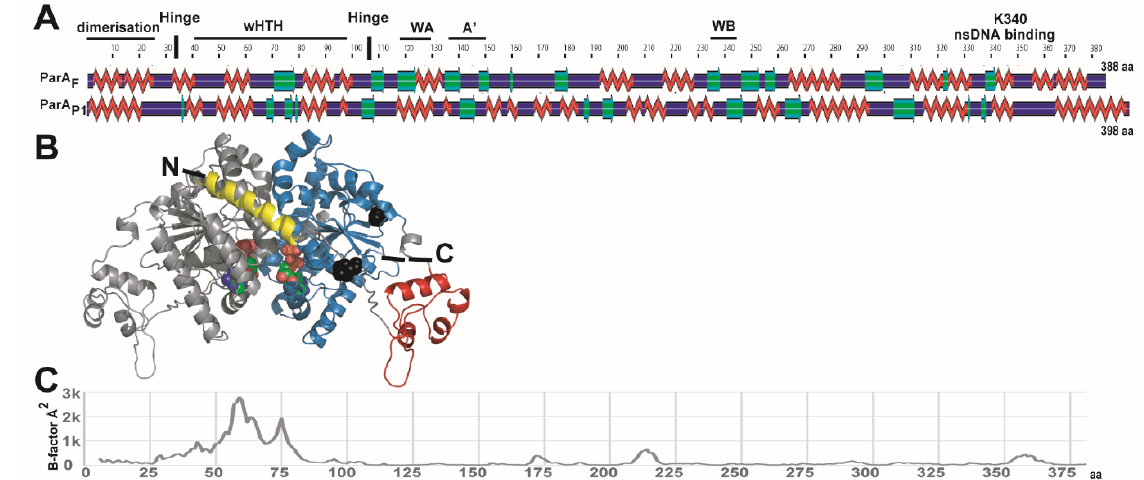
Figure 4. Structural similarity of ParA F with ParA P1 . ( A ) Alignment of secondary structures predicted for ParA F (388 aa) and derived from X-ray crystallography for ParA P1 (398 aa). The comparison was generated by POLYVIEW2D. α -helices and β -sheets are displayed in red and green, respectively. Domains and motifs for ParA F are indicated as follows: dimerization (1–27 aa), wHTH (winged helix turn helix; 40–100 aa), WA (Walker A; 114–122 aa), WA’ (Walker A’; 139–149 aa), WB (Walker B; 246-251 aa), nsDNA binding K340 (lysine 340). Vertical bars represent Hinge positions predicted by HingeProt analysis. ( B ) Model of ParA F 3D structure generated by Swiss-Model using ADP-ParA P1 structure as a reference (see Materials and Methods). The two monomers are colored separately in grey and blue. For the right monomer, the first α -helix and the wHTH are displayed in yellow and red, respectively, and the Nter (N) and Cter (C) are indicated. Hinge positions are represented by black spheres. Each monomer contains an ADP represented with spheres, red for oxygen (O), green for carbon (C), blue for nitrogen (N) and orange for phosphate (P). ( C ) The wHTH of ParA F undergoes a large conformational change. The B-factor, estimating the atomic fluctuation and expressed in angstrom (A 2 ), was calculated from residues 5 to 381 from 40 ns Molecular Dynamic trajectories. The local mobility within the molecule is mostly restricted to the region encompassing the wHTH motif.